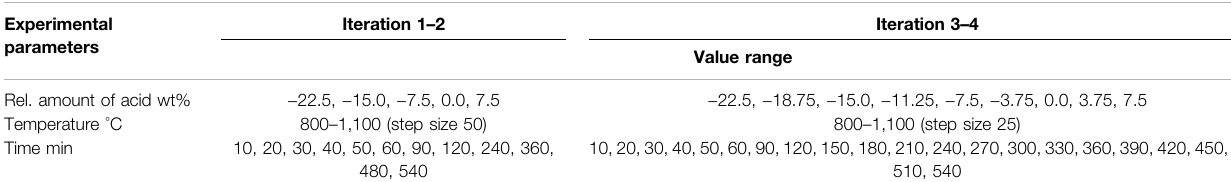
TABLE 1 | Range of experimental parameters for selection.